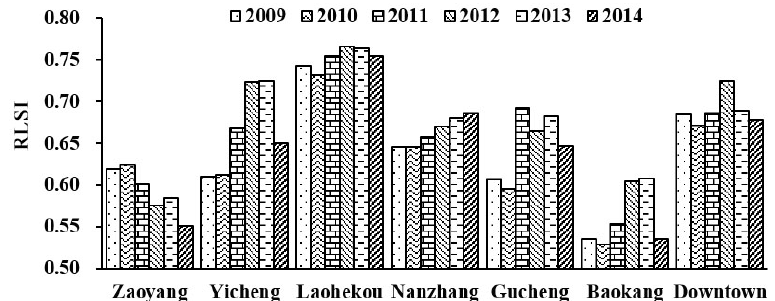
Figure 5. Temporal variation process of RLSI in different regions of Xiangyang City.